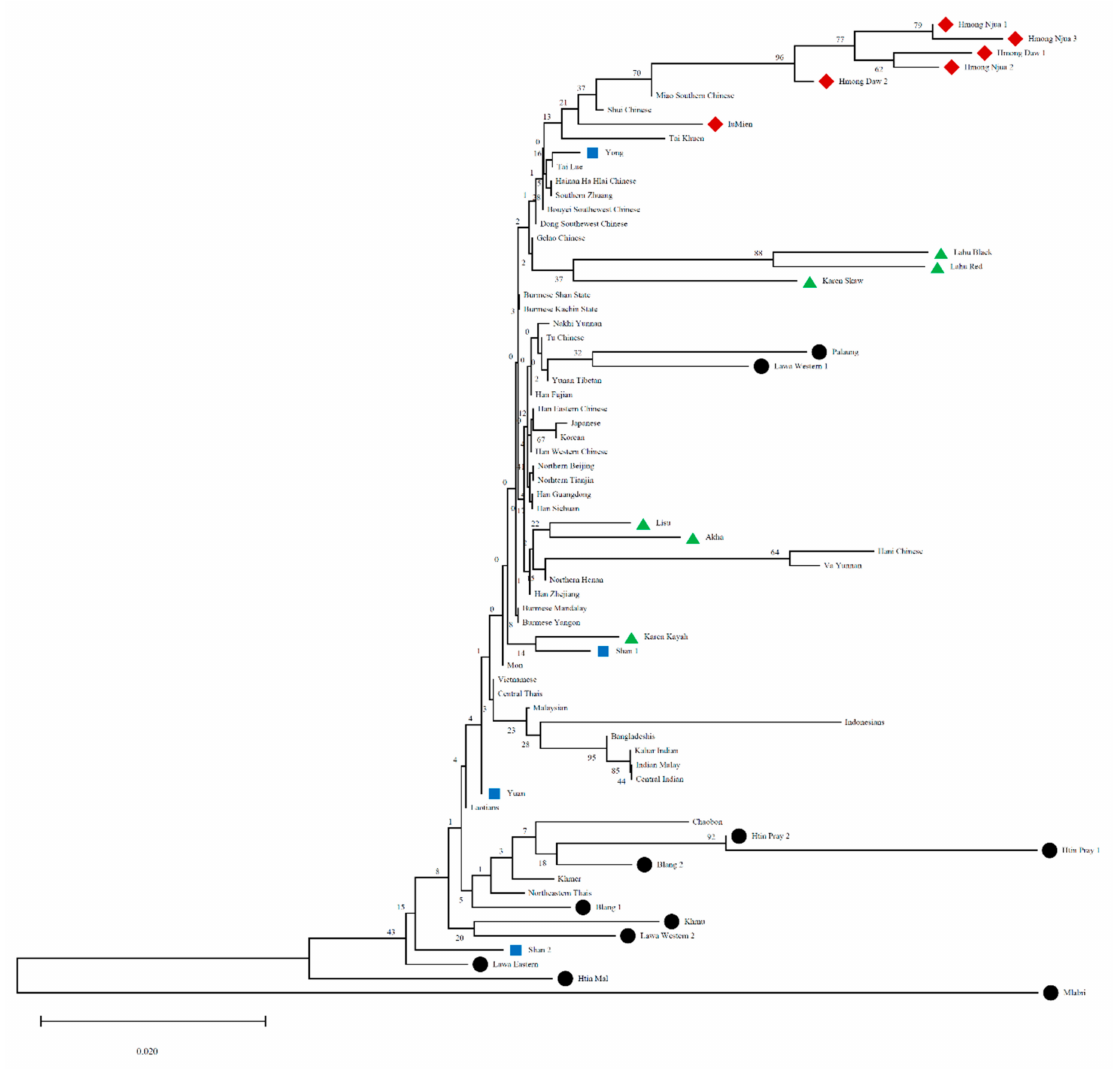
Figure 5. Neighbor-joining tree constructed from F ST genetic distance based on the allelic frequencies of 13 STR loci among total 69 populations. The different symbols indicate the studied populations from northern Thailand that were used in previous analyses. Red diamonds, green triangles, black circles, and blue squares represent HM-, ST-, AA-, and TK-speaking populations,